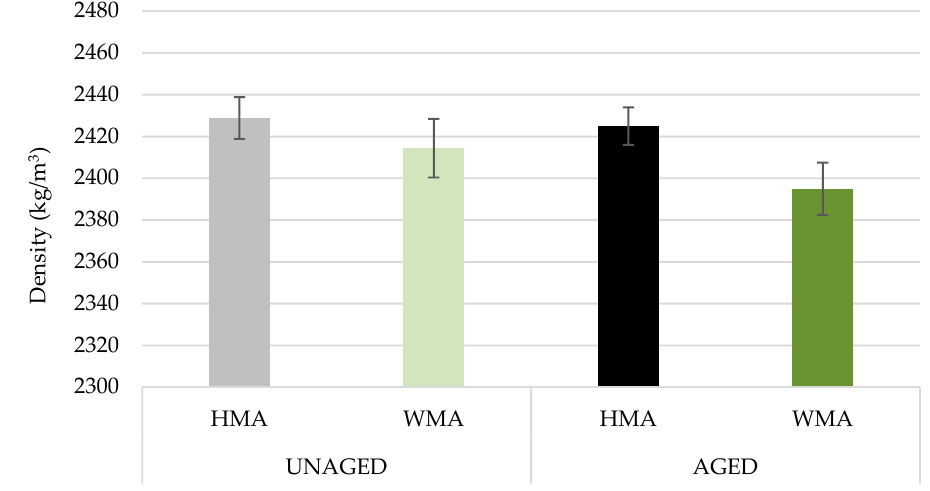
Figure 5. Average bulk densities of the beams.